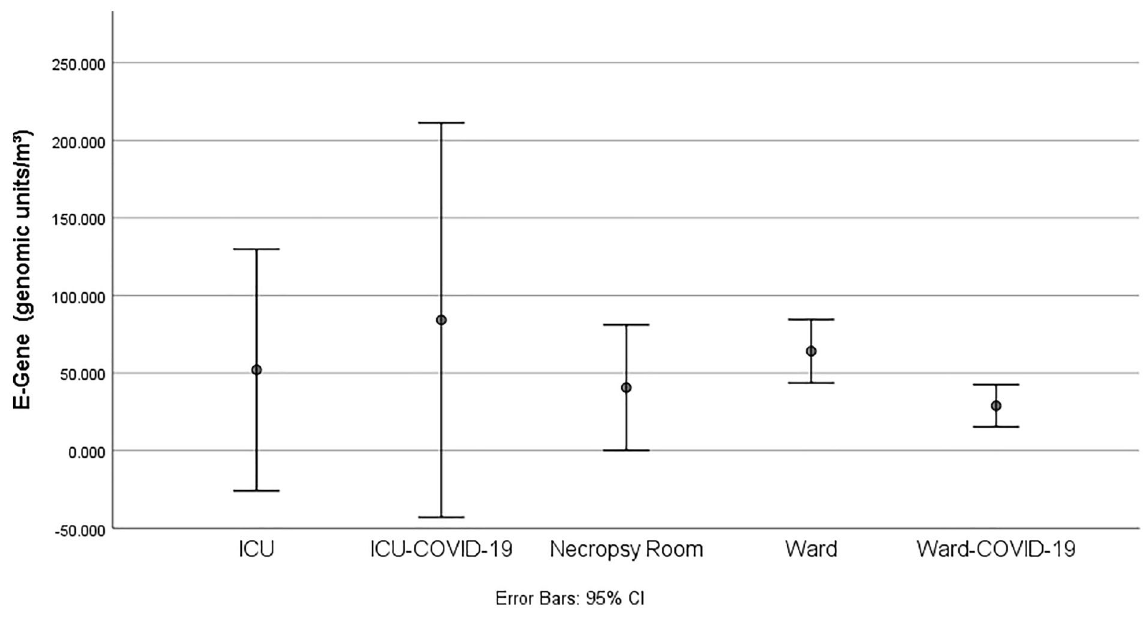
Figure 1. E-gene concentrations according to the